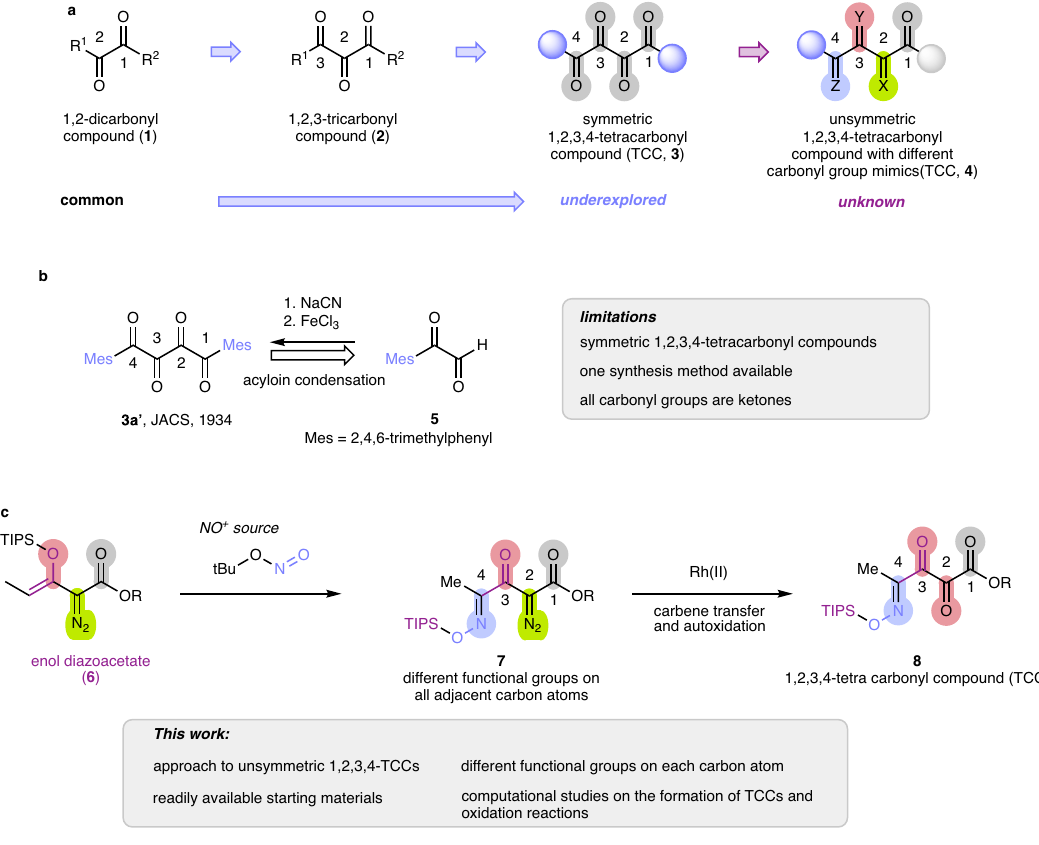
Fig. 1 | Synthesis of 1,2,3,4-tetracarbonyl compounds. a Polycarbonyl com- pounds. b Conventionalsynthesisof1,2,3,4-tetracarbonylcompounds. c Thiswork: